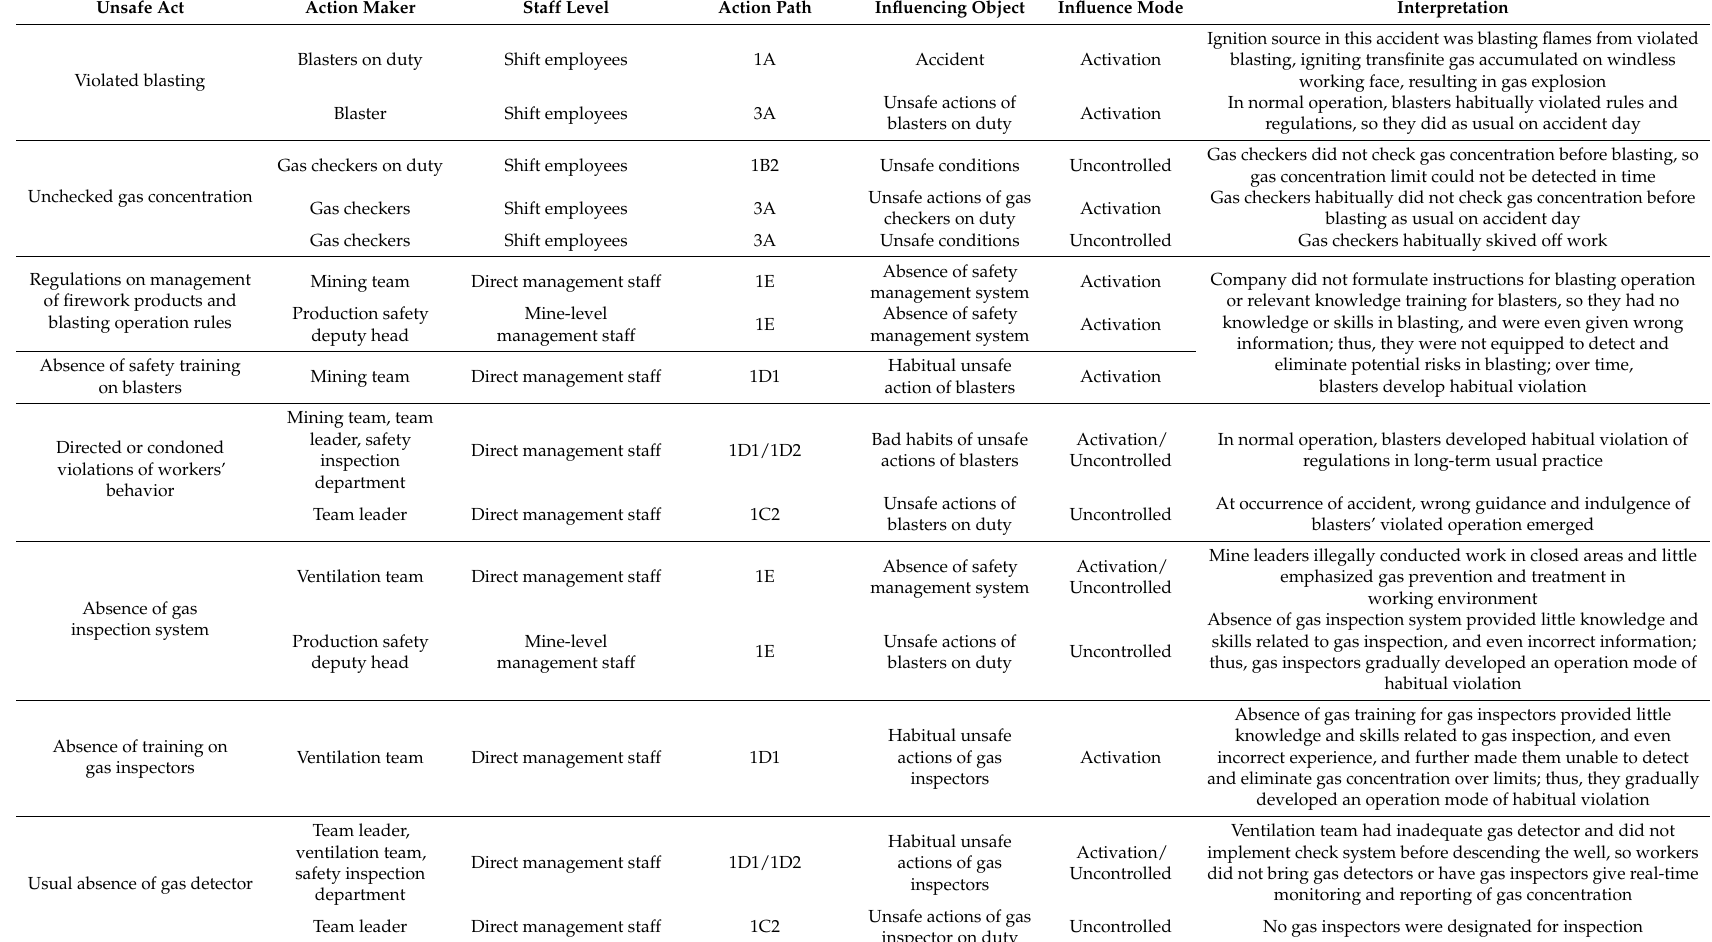
Table 1. Analysis of employees’ unsafe acts in the organization of Ruizhiyuan coal